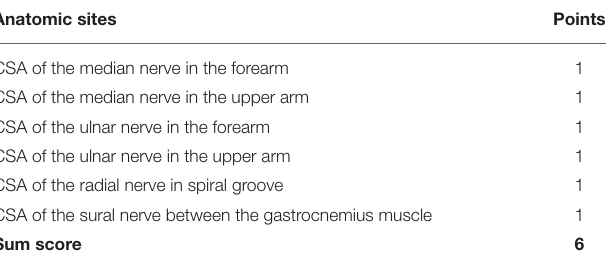
TABLE 1 | Overview of the anatomic sites and scoring system of adjusted Bochum ultrasound score. Anatomic sites